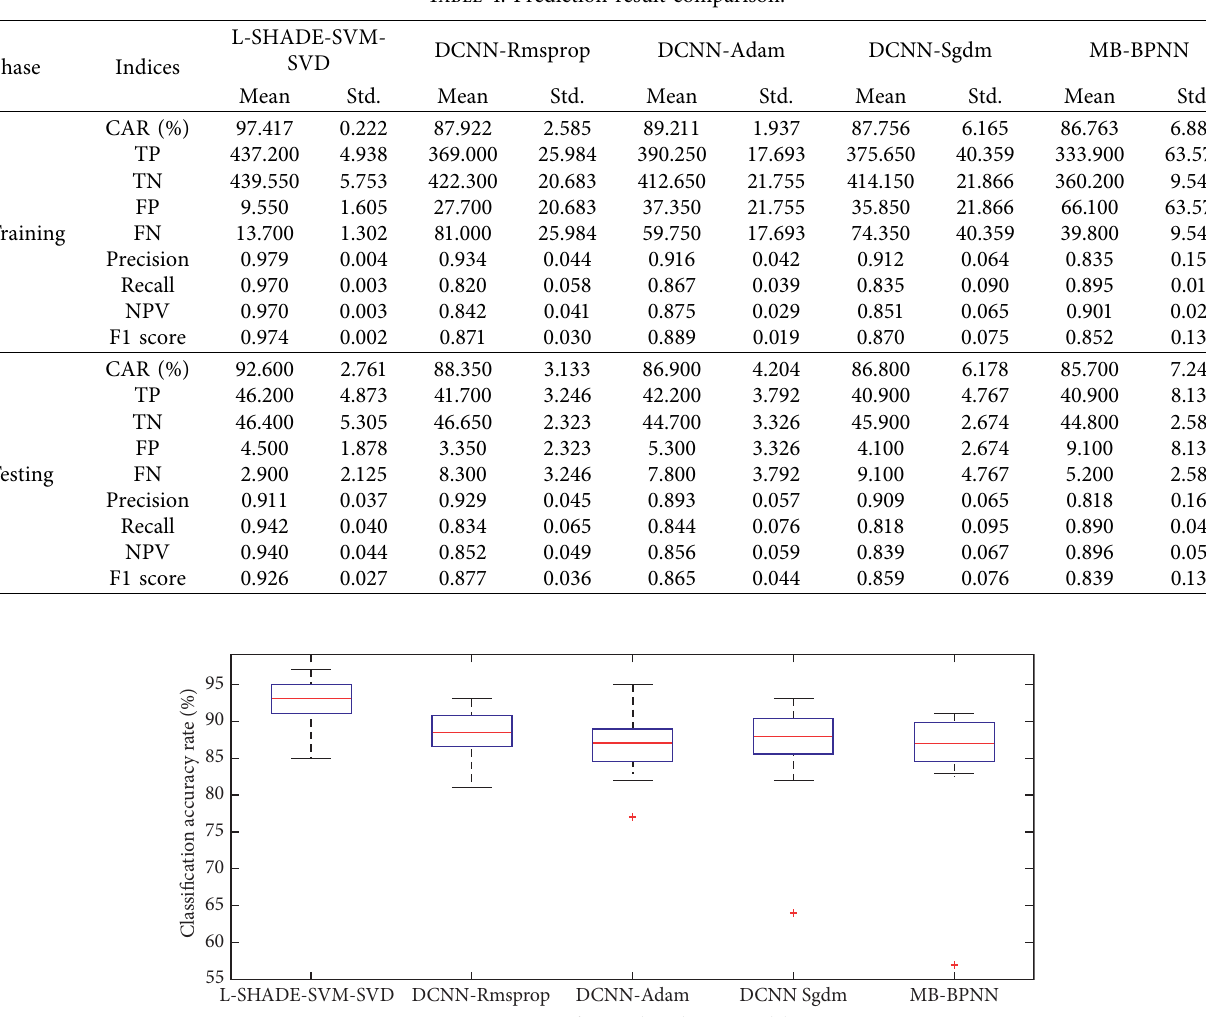
Table 4: Prediction result comparison.